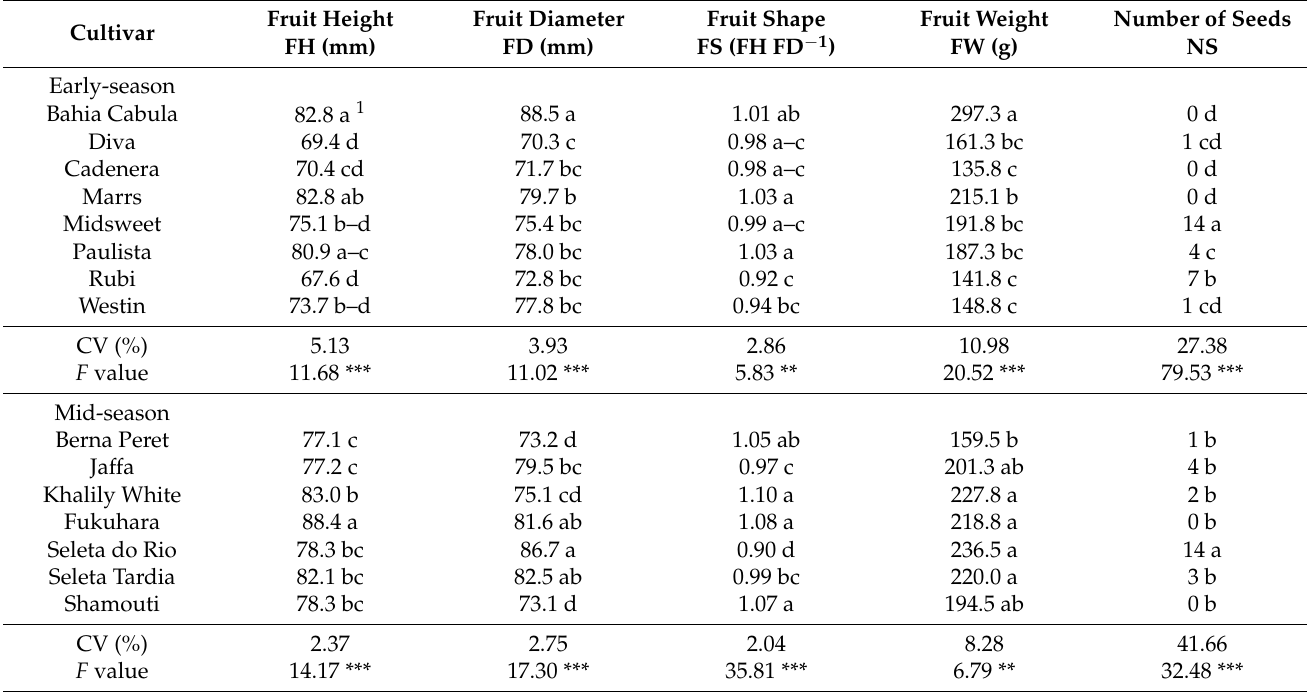
Table 4. Fruit quality of 15 early-season and mid-season sweet orange cultivars produced in Guairaç á , Paran á , Brazil, in the 2019 cropping